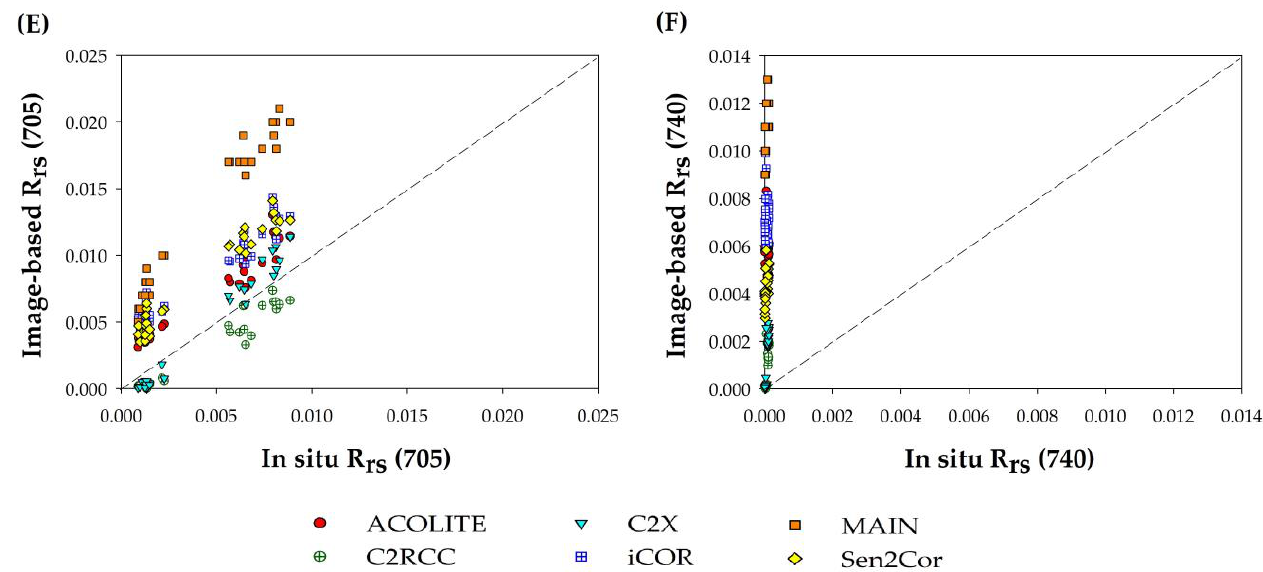
Figure 4. Performance assessment of the atmospheric correction routines (ACOLITE, C2RCC, C2X, iCOR, MAIN and Sen2Cor) for the Sentinel-2/MSI spectral bands. ( A ) Band 1 (443 nm), ( B ) Band 2 (490 nm), ( C ) Band 3 (560 nm), ( D ) Band 4 (665 nm), ( E ) Band 5 (705 nm) and ( F ) Band 6 (740 nm)